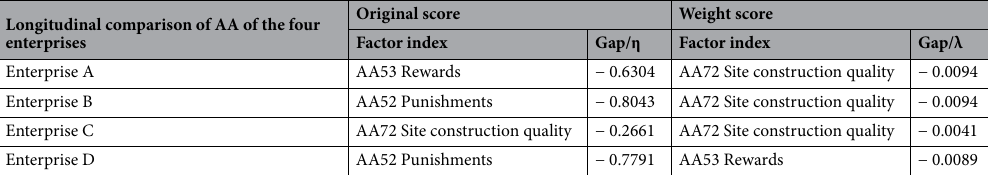
Table 18. Analysis of the shortcomings of the basic index scores of the safety management in four companies (AA of the first-level indexes)—longitudinal comparison.